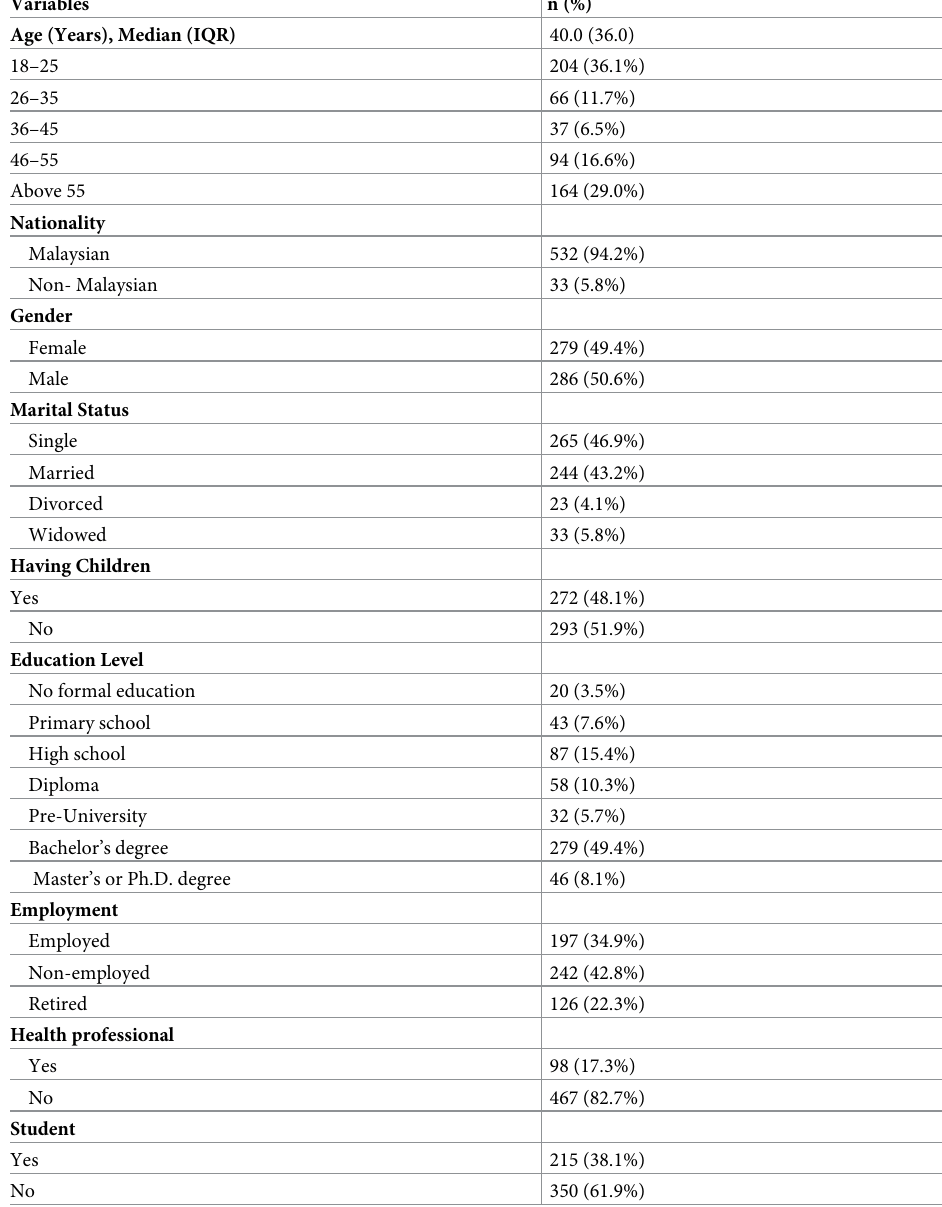
Table 1. General population: Socio-demographics (N = 565).